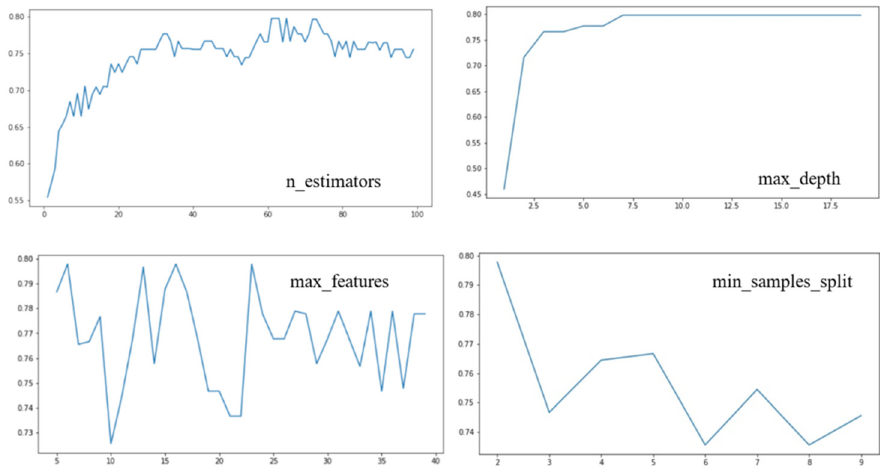
Figure 14. Parameter adjustments of the random forest classification algorithm; the x-axis is the number of input feature factors, and the y-axis is the classification efficiency of the classifier after inputting feature factors.